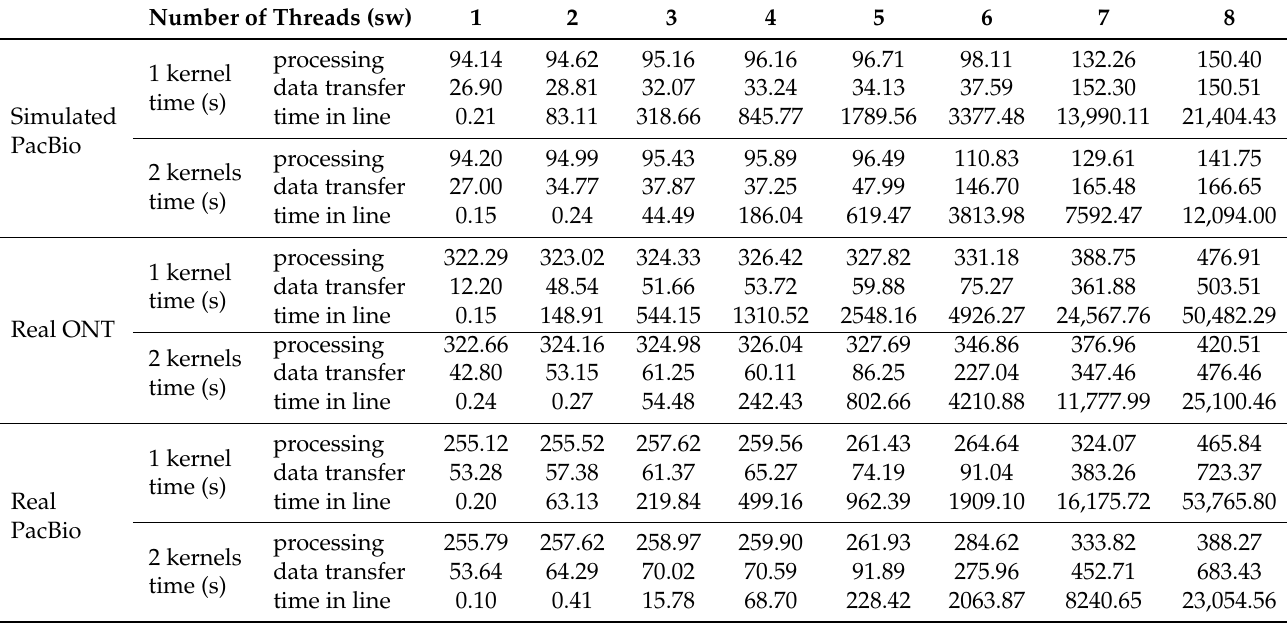
Table 7. Processing, transferring, and waiting times in the Minimap2-GACT-X